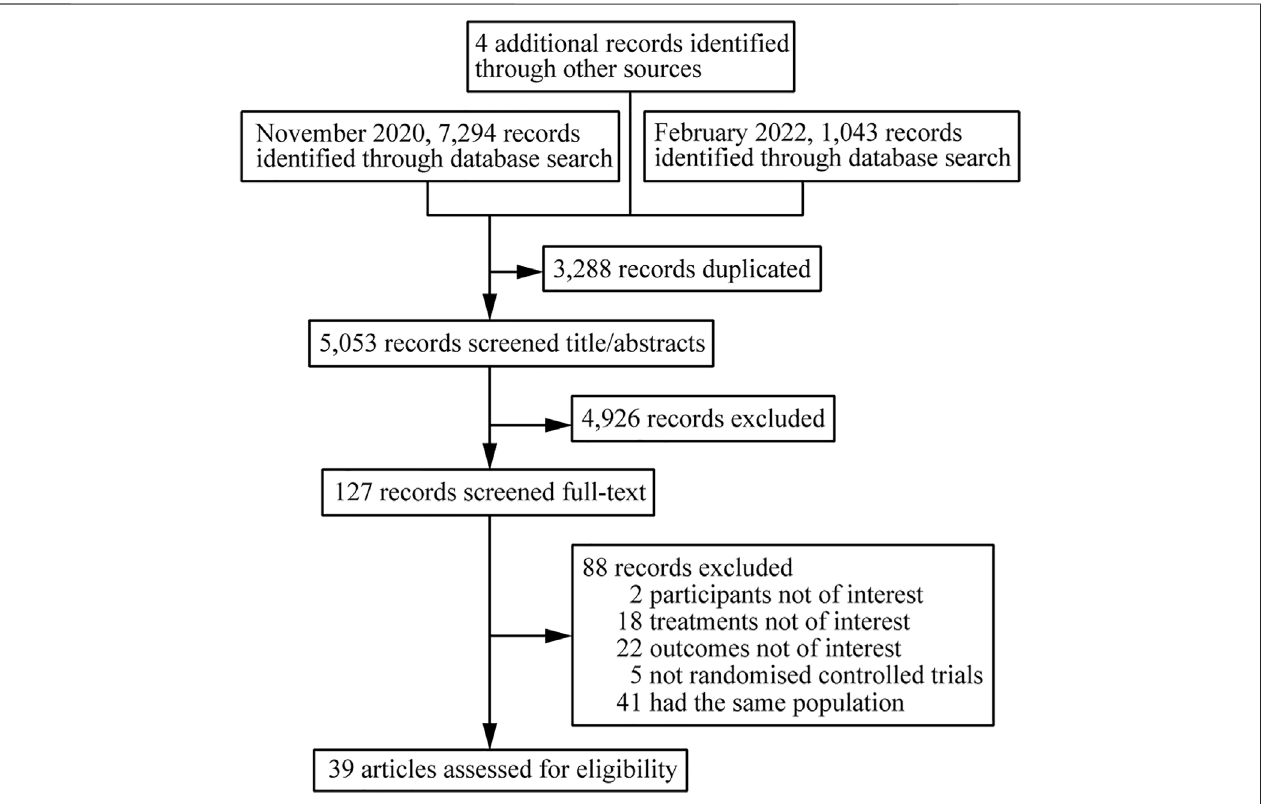
FIGURE 1 | Flow chart of study